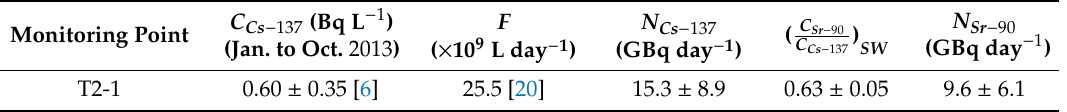
Table 3. Estimation of the release rates for 90 Sr and 137 Cs into the ocean from the FDNPP site in May 2013. C : activity; F : conversion factor; N : release